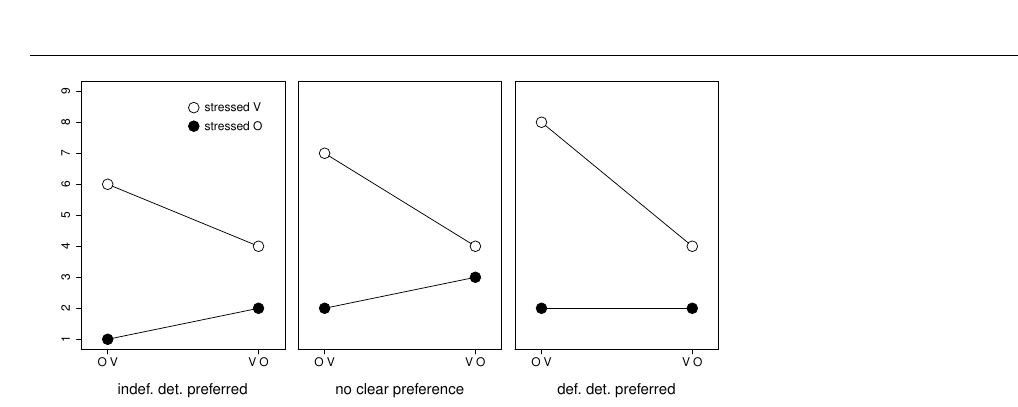
Medians for the items from experiment 1 with a definite context, grouped based on the results of the forced choice test